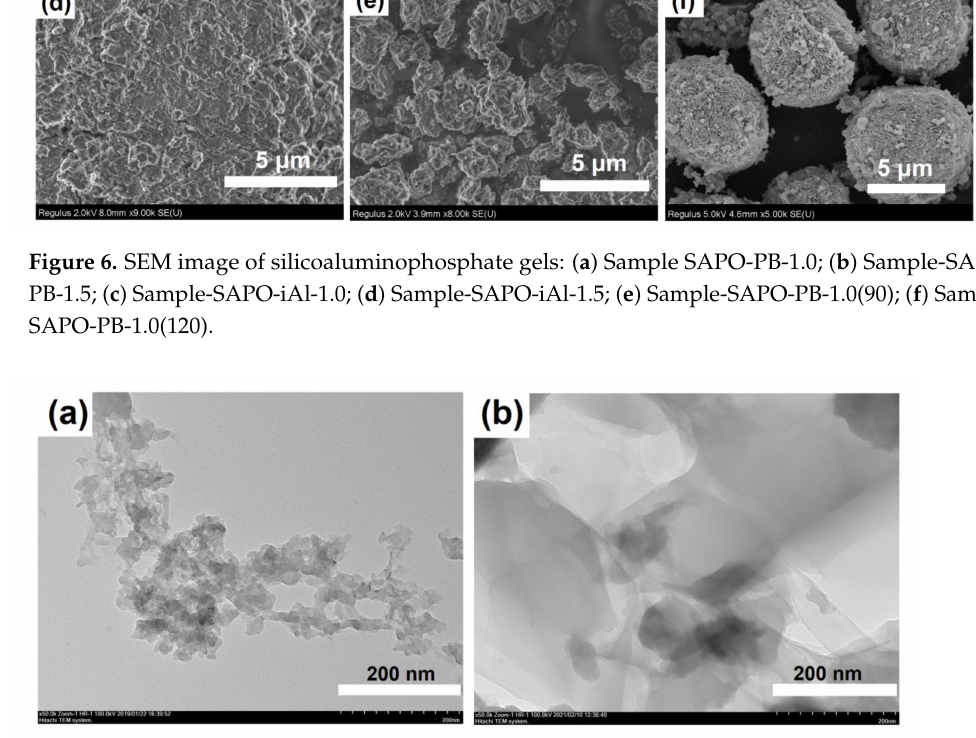
Figure 7. TEM image of silicoaluminophosphate gels: ( a ) Sample-SAPO-iAl-1.0; ( b ) Sample-SAPO-